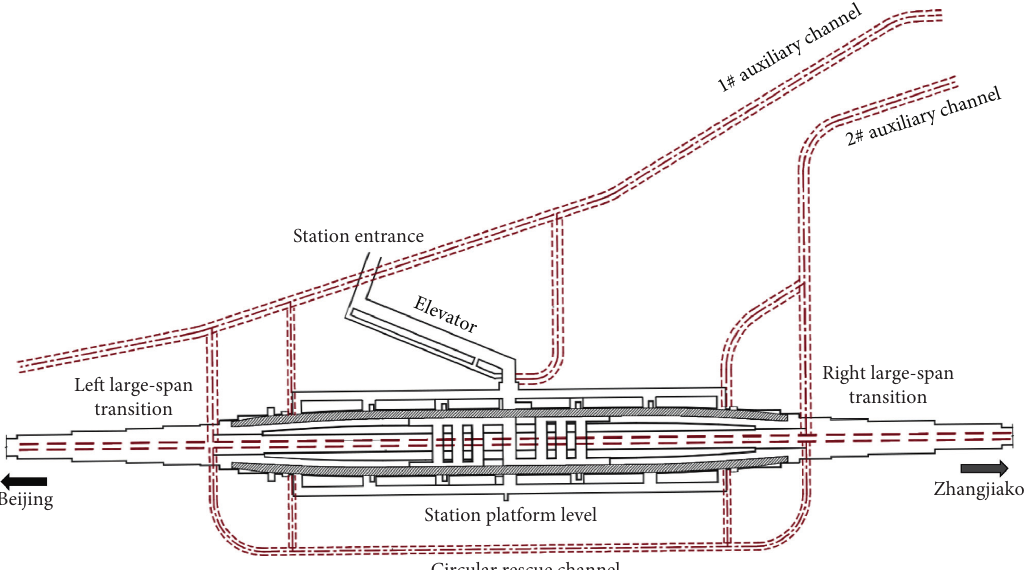
Figure 2: Distribution of caverns at the great wall station.